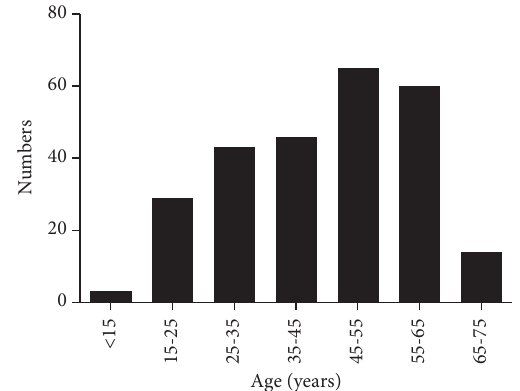
Figure 2: Age distribution. The histogram represents the number and distribution of patients in different age